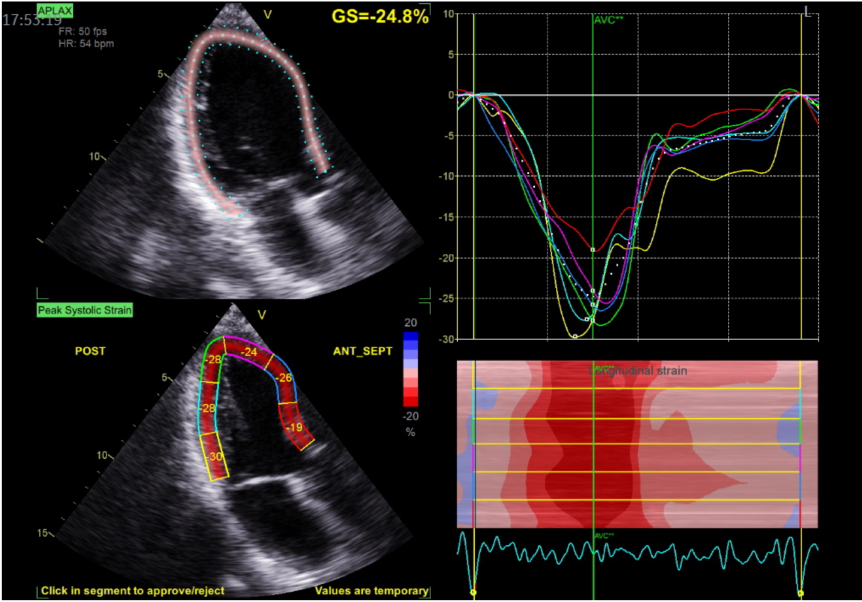
Figure 3. The example of representative case with speckle-tracking analysis including MAD